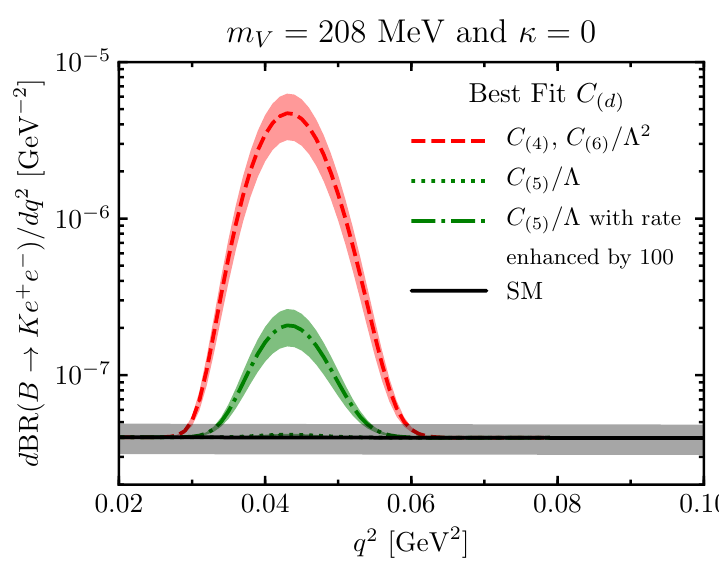
Figure 4 . The di(cid:11)erential branching ratio d BR( B ! Ke + e (cid:0) ) =dq 2 in the SM (solid black) and in the presence of a light vector resonance with mass 208 MeV produced via the operators Q (4) (dashed red), Q (dotted green) and Q (dashed red). In each case, we use the best-(cid:12)t value for (5) (6) the corresponding Wilson coe(cid:14)cients (see table 1). The predictions for Q and Q are identical. (4) (6) The Q peak is much less prominent. For illustration we also show this case after enhancing the (5) NP rate by a factor of 100 (dotted dashed